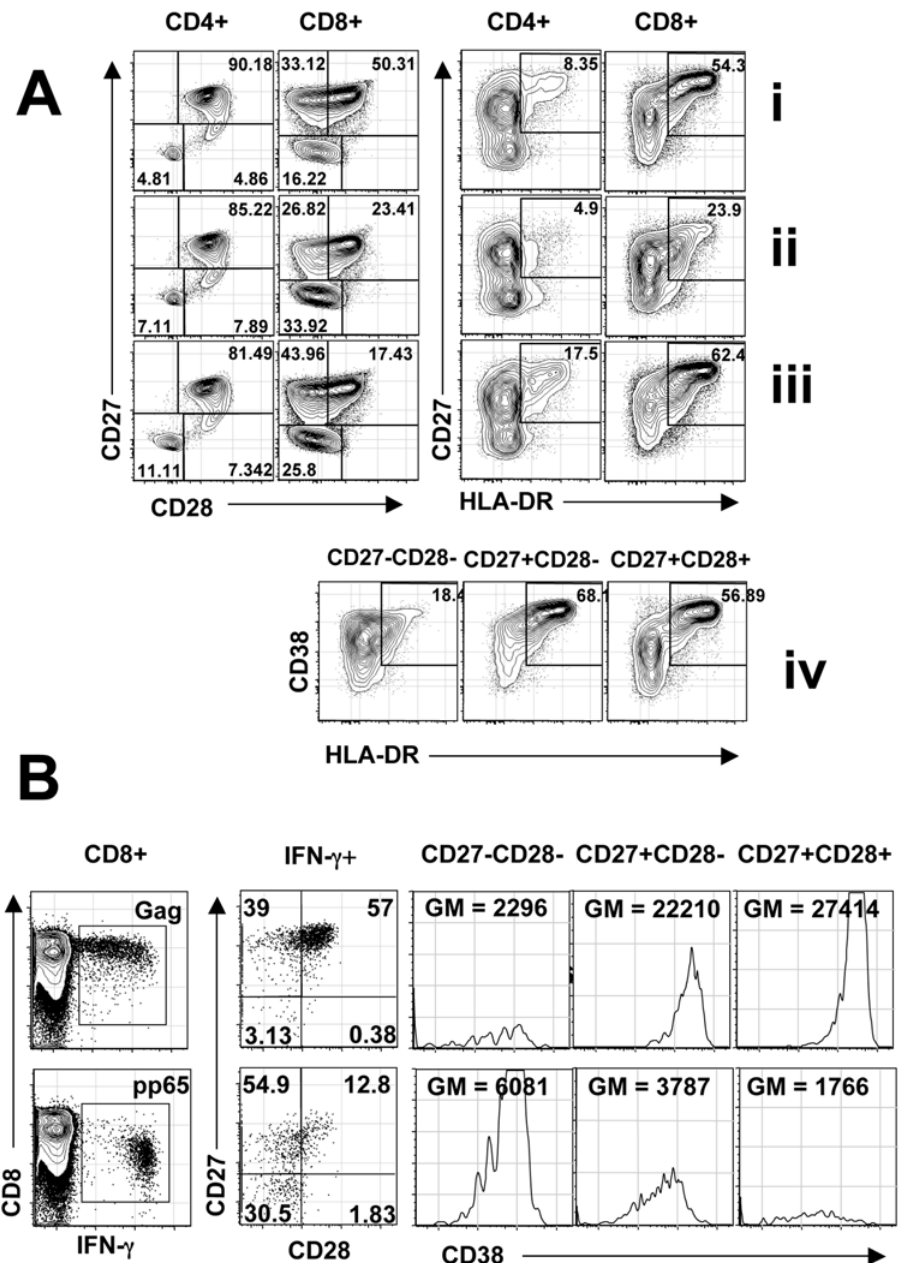
Figure 1. Expression of Maturation and Activation markers on Total CD4 + and CD8 + T cells . (A): before initiation of ART (i); after treatment (ii); and post-ART (iii). Activation is also shown on CD27 and CD28 subsets from CD8 + T cells post-ART (iv). Expression of Maturation and Activation markers on HIV Gag- and CMV pp65-specific T cells (B). CD27 and CD28 expression and CD38 mean fluorescent intensity (MFI) is shown on IFN- c + CD8 + T cells. (GM=Geometric